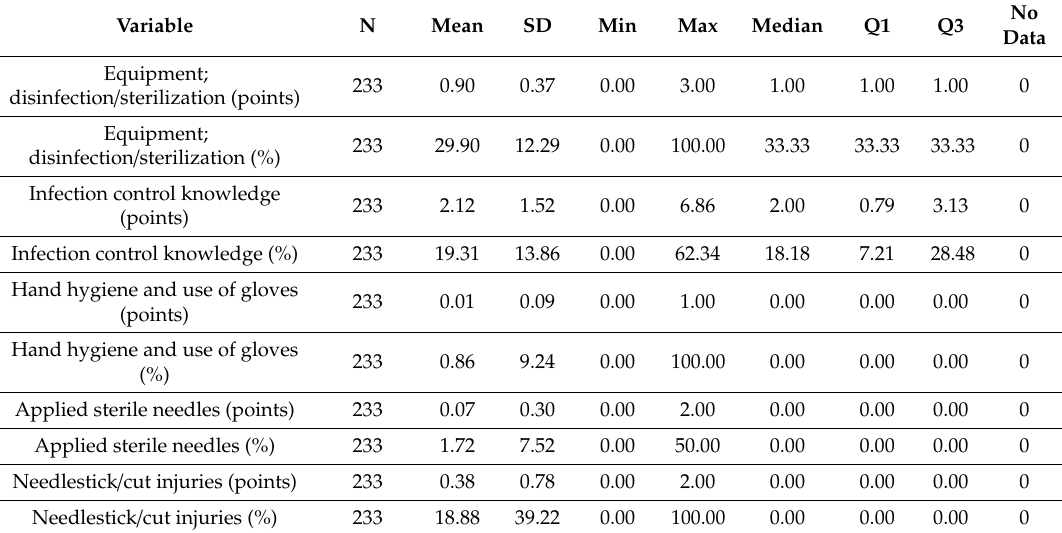
Table 4. Scoring the risk to a person performing a tattoo or risk modifiers.